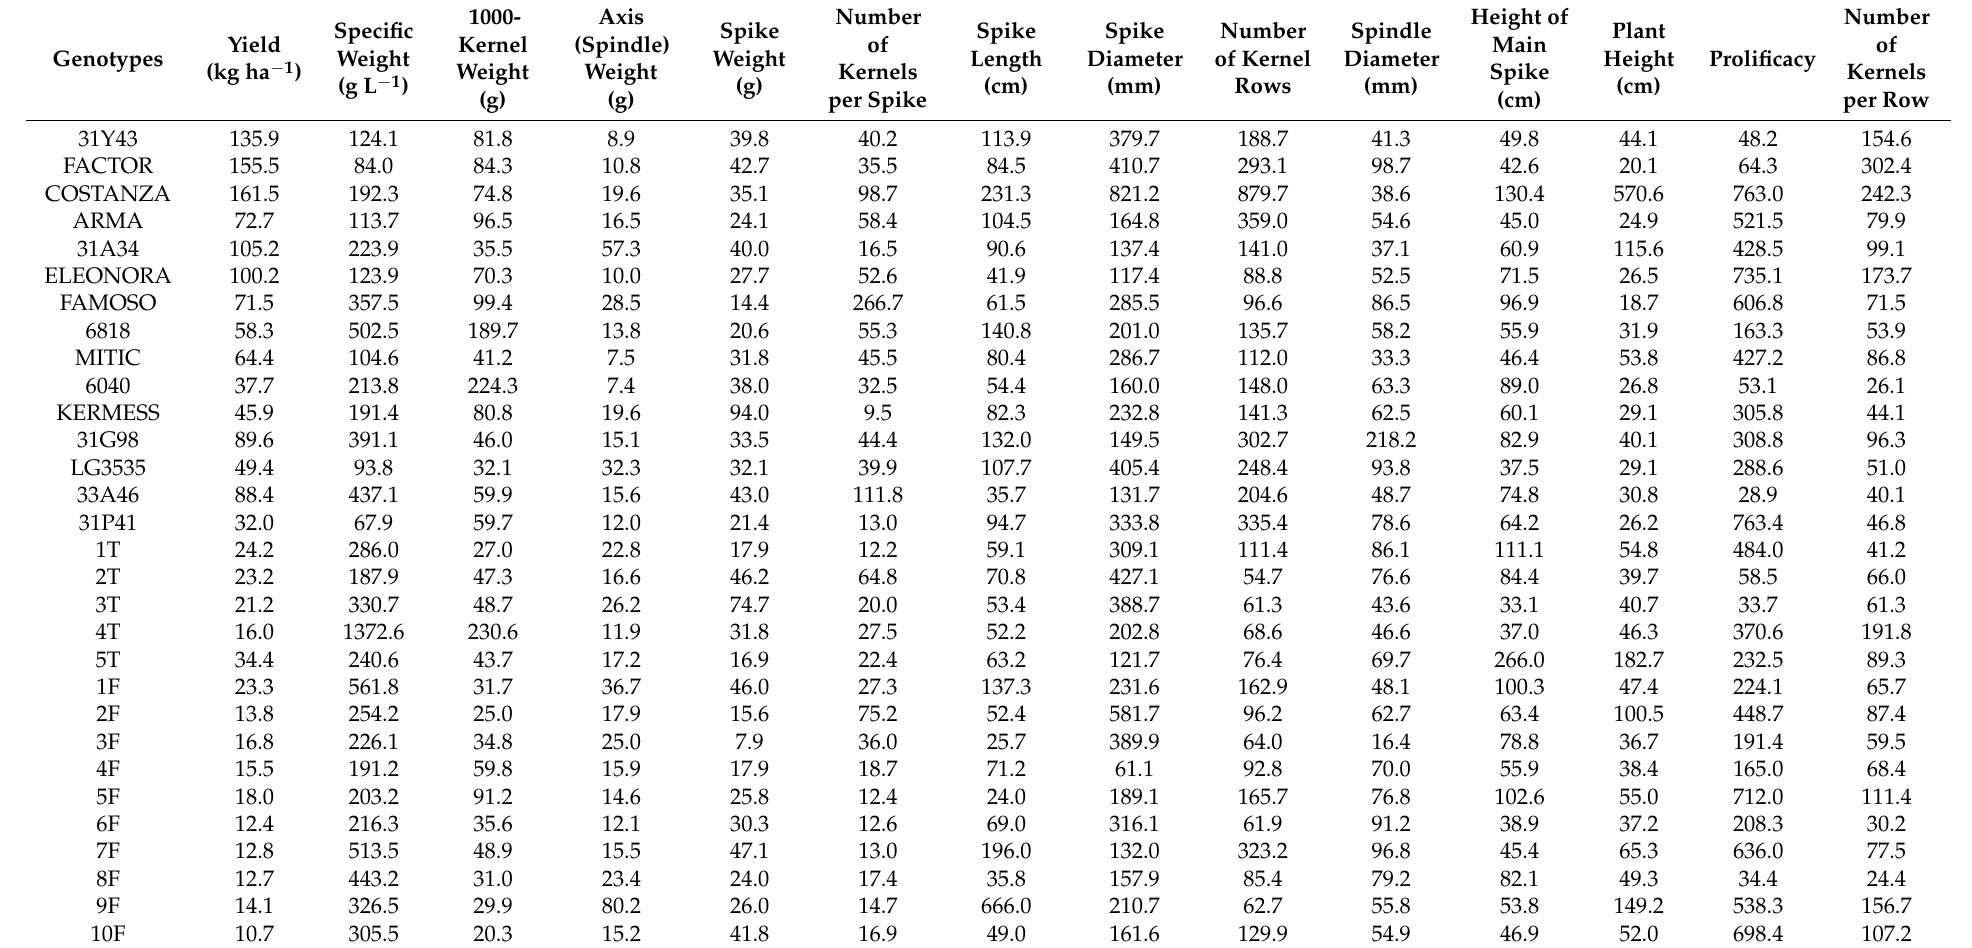
Table 6. Trait stability index ( x / s ) 2 across genotypes and environments for tested traits: yield, yield (kg ha − 1 ), specific weight (g L − 1 ), 1000-kernel weight (g), axis (spindle) weight (g), spike weight (g), number of kernels per spike, spike length (cm) and diameter (mm), number of kernel rows, spindle diameter (mm), main spike and plant height (cm), prolificacy, and number of kernels per row, in Kalambaka